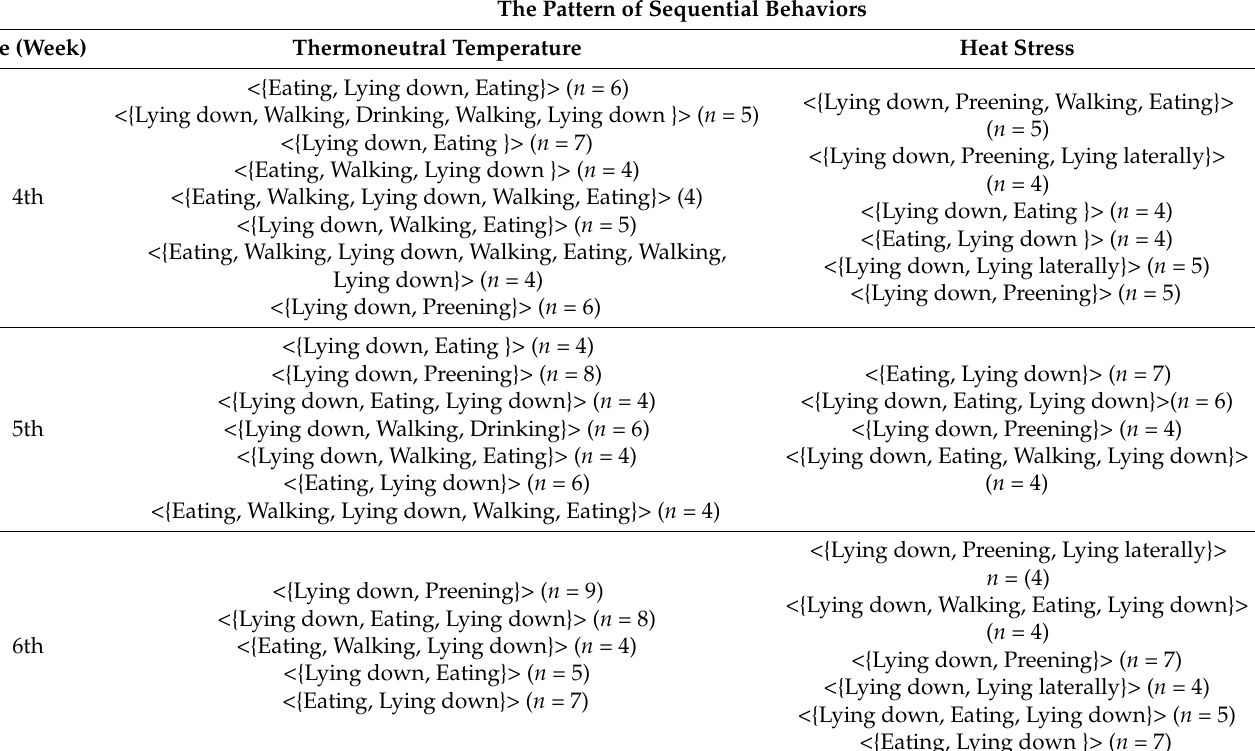
Table 5. Main patterns of sequential behavior for thermoneutral conditions and thermal stress (sequence size ranging from 2 to